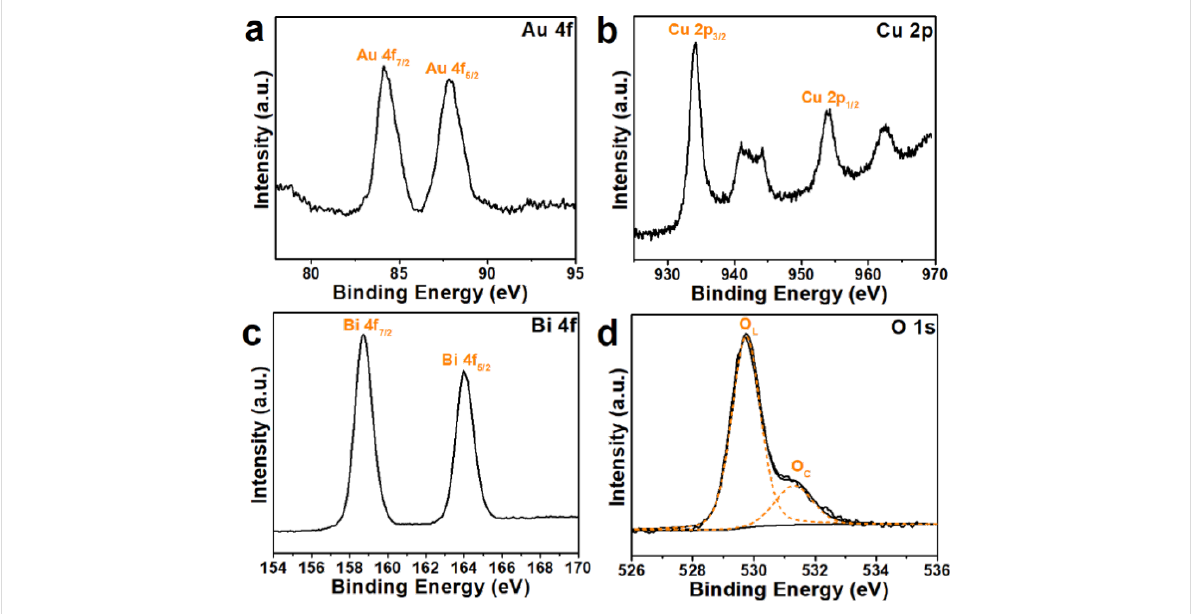
Figure 5: XPS high-resolution spectra of the 2.5 wt % Au/CBO composite: (a) Au 4f; (b) Cu 2p; (c) Bi 4f and (d) O 1s.